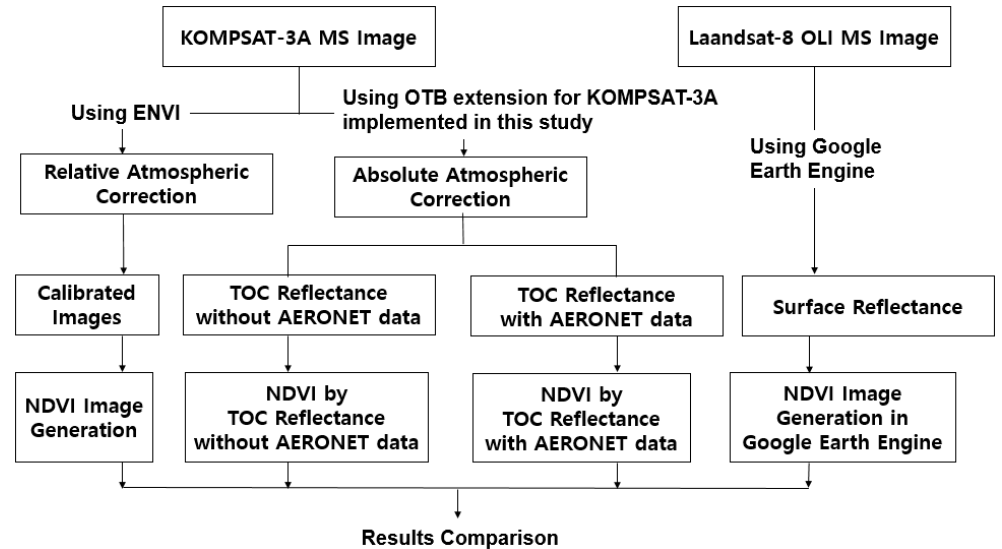
Figure 2. The workflow of this study and datasets used. The notation TOA, TOC, and NDVI mean Top-of-Atmosphere, Top-of-Canopy, and normalized difference vegetation index, respectively.